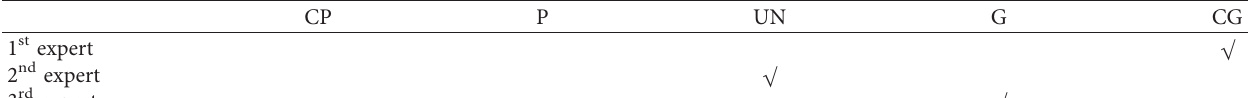
Table 3: Evaluation result of D1.